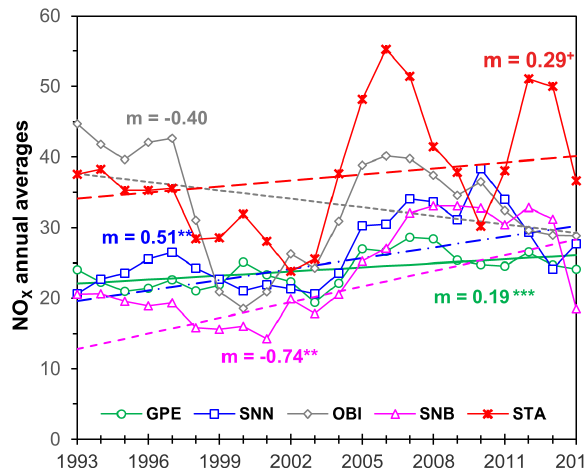
Figure 13. Long-term trends for NO x at the five monitoring sites within the MMA during 1993–2014. The dashed lines represent the Sen slopes. Annual NO x rates of change are expressed as the slope (m) of the dashed lines in units of ppbyr − 1 . Levels of confidence are represented as + = p < 0 . 1, ∗ = p < 0 . 05, ∗∗ = p < 0 . 001, and ∗∗∗ = p < 0 .